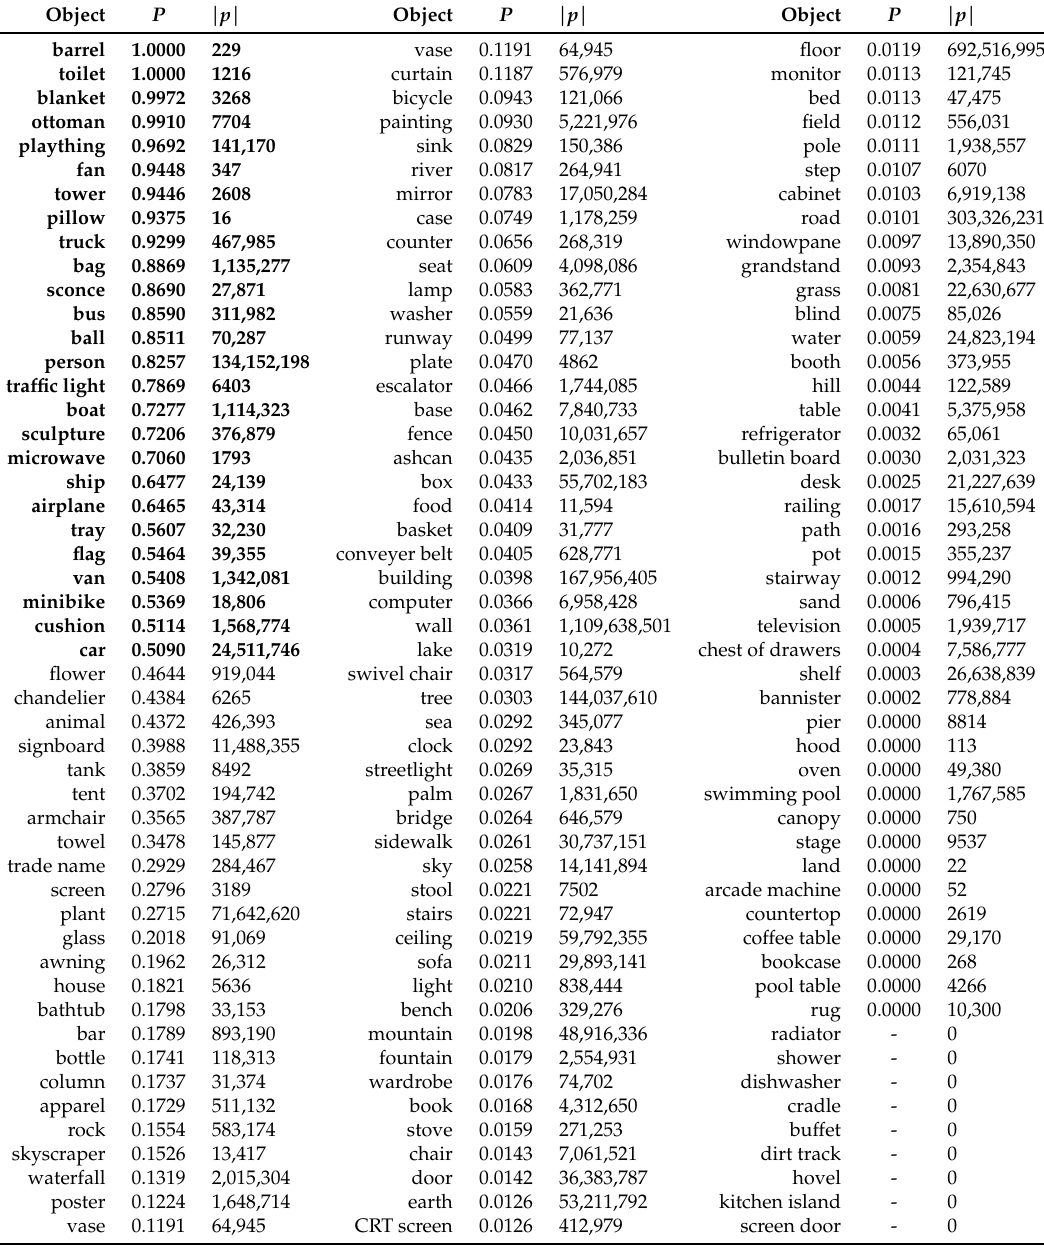
Table 2. Result of the MP universal estimators applied on the universal training dataset processed by PSPNet. For each object class o i , we give the name in the column “Object”, the probability (cid:12) (cid:0) (cid:1) P G = fg in the column “ P ” and the number of pixels whose most probable object class is o i (cid:12) ˆ O = o i in the column “ | p | ”. The probabilities of at least 0.5 are in